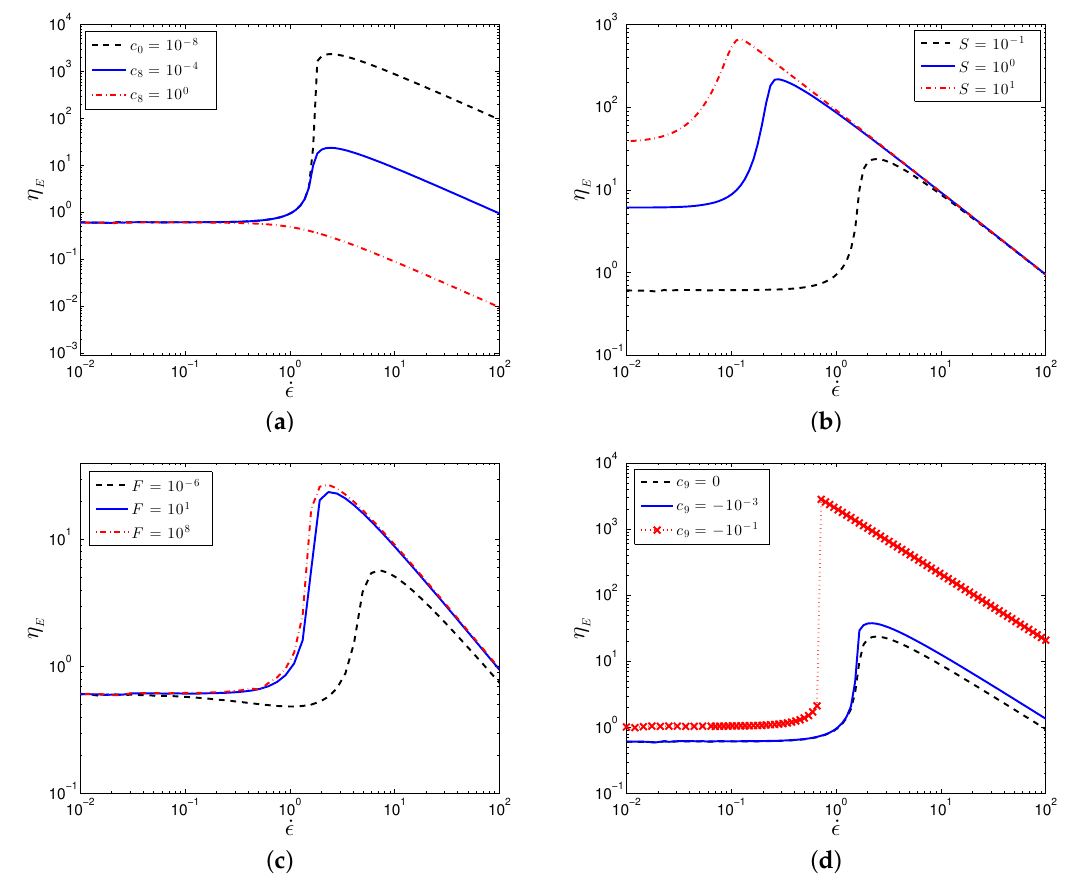
Figure 5. Plot of the particle contribution to the extensional viscosity, η E = ( Π xx − Π yy ) /˙ (cid:101) , against extension rate for varying values of ( a ) c 8 , ( b ) S , ( c ) F , and ( d ) c 9 . Parameter values are: S = 10 − 1 , F = 10, c 3 = − 23.5,